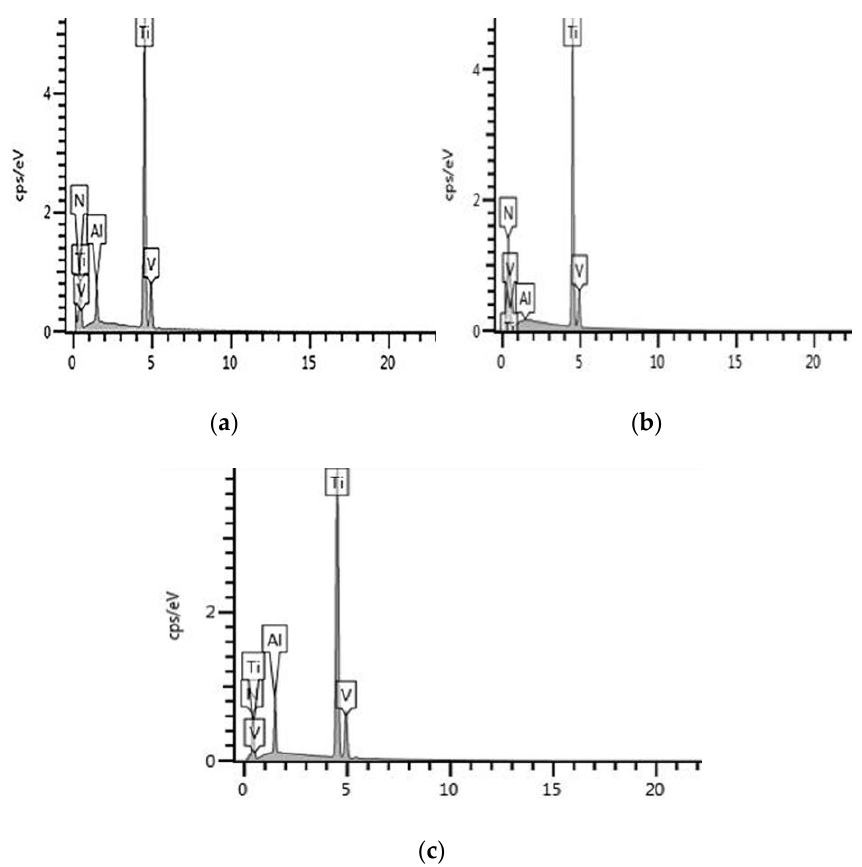
Figure 7. Energy spectrogram of the surface of the sample after cleaning ( a – c are the energy spectrogram of samples 1, 2, and 3, respectively).